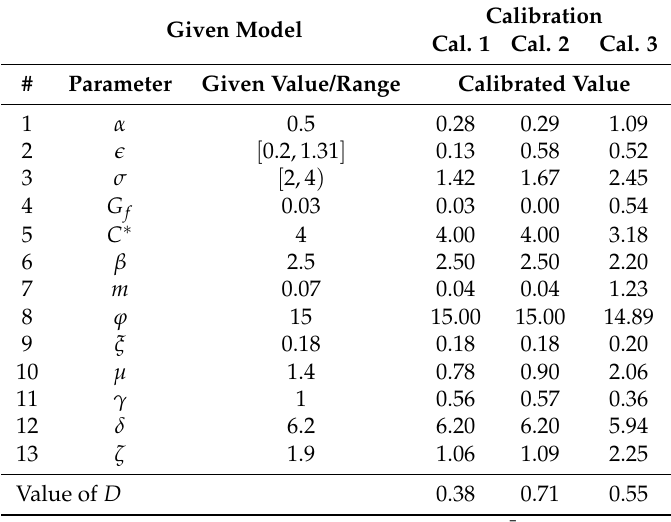
Table 3. Harrod model